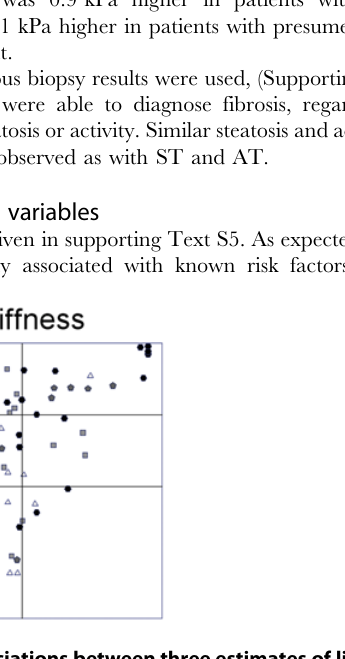
Figure 2. Associations between three estimates of liver fibrosis: FibroTest, liver stiffness measurements and fibrosis stage at biopsy, in 266 patients with recommended criteria. Each point represents the result of biopsy stage using METAVIR scoring system: white circle F0 (no fibrosis), light grey triangle F1 (portal fibrosis), grey square F2 (few septa), light black pentagon F3 (many septa) and dark black hexagon F4 (cirrhosis). These points are distributed according to FibroTest value on the vertical axis and liver stiffness measurements on horizontal axis. The first horizontal line is the FibroTest cutoff (0.48) for stage F2, the second (0.73) for F4. The first vertical line is the stiffness cutoff (8.8 kPa) for stage F2, the second (14.5 kPa) for F4.